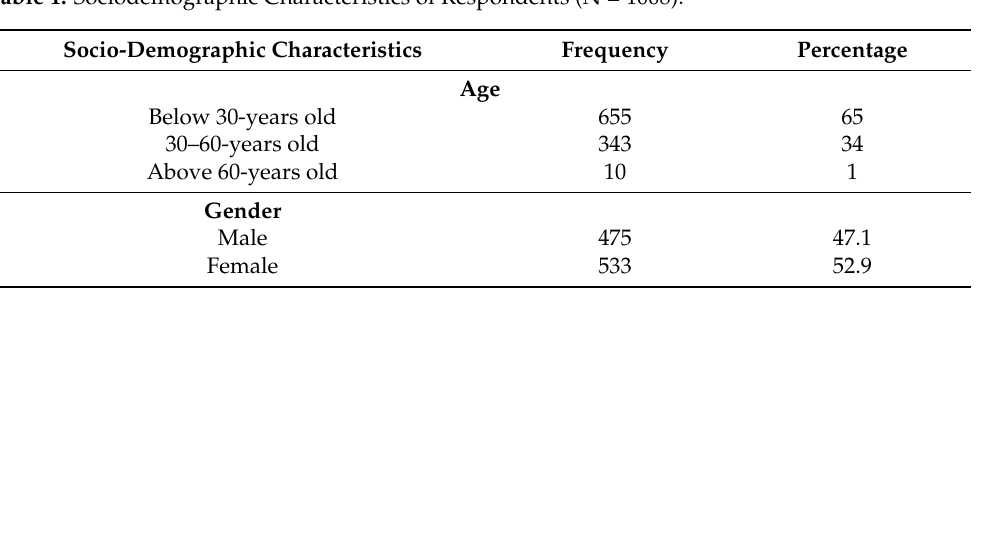
Table 1. Sociodemographic Characteristics of Respondents (N =